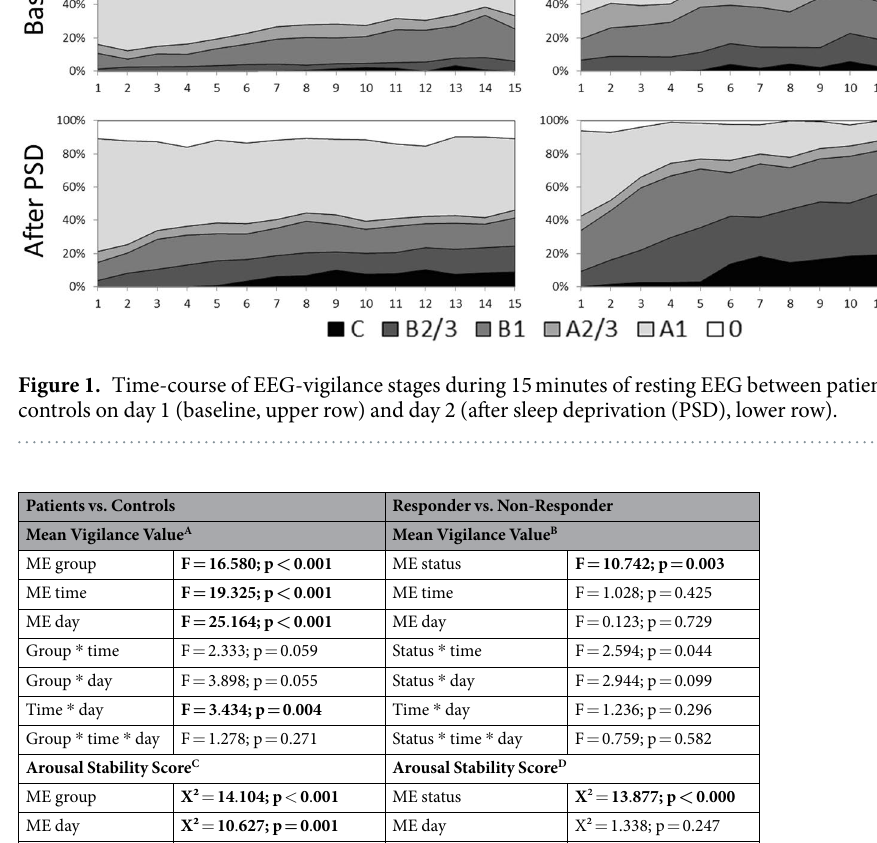
Table 3. Results on changes of the Mean Vigilance Value and the Arousal Stability Score in patients vs. healthy controls (left part) and responders vs. non-responders to sleep deprivation (right part) from baseline to after sleep deprivation. Annotations: ME = Main Effect; Group (depressive patients vs. healthy controls), Status (responders vs. non-responders), time (recording minutes 1–15), and day (assessment days: baseline vs. after sleep deprivation). A Repeated measure ANOVA. B Repeated measures ANCOVA (with age as covariate). C Generalized estimating equation. D Generalized estimating equation, including age as cavariate (main effects of age and age * day as well as age * time interactions were